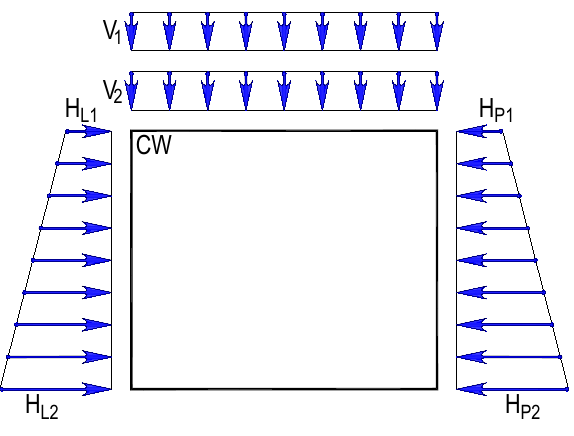
Figure 5: Load denotations and load action